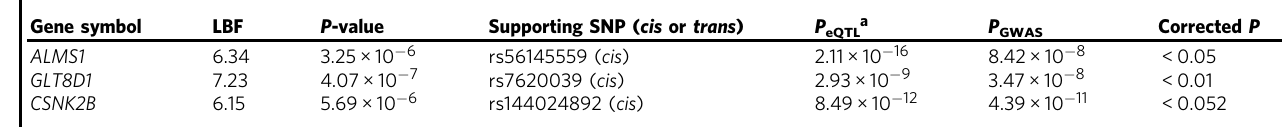
Table 2 Validation of ALMS1 , GLT8D1 , and CSNK2B as schizophrenia risk genes using independent brain eQTL data set ( Sherlock integrative analysis)